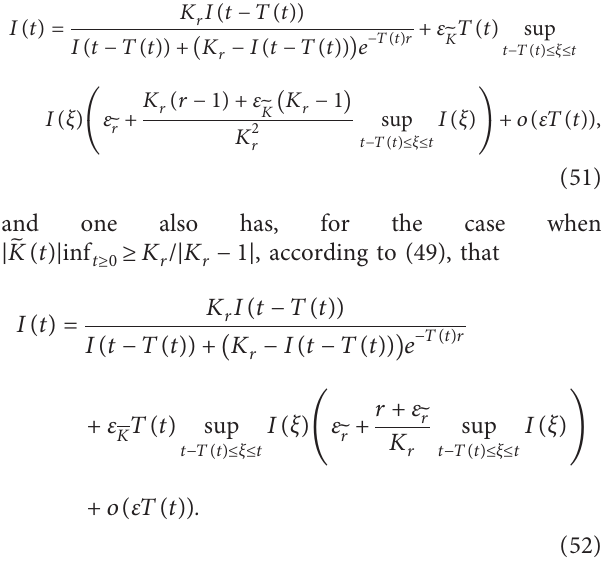
Figure 1: Evolution of the SIR model describing the spread of COVID-19 in